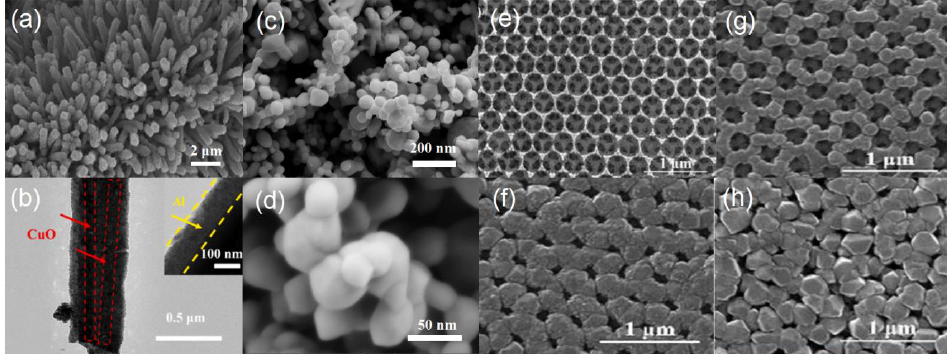
Figure 3. Typical FESEM image ( a , b ) of Al/CuO EMs by electrochemical and magnetron sputtering method [22] Copyright 2021, Journal of Alloys and Compounds, typical FESEM images with low ( c ) and high ( d ) resolution of the superhydrophobic Al/CuO energetic films [54] Copyright 2018, Materials Letters, ( e ) the 3D porous CuO prepared bycolloidal crystal template of polystyrene microspheres [56], followed by ( f ) the 3D Al/CuO EMs after magnetron sputtering of Al with different thicknesses of ( f ) 200 nm, ( g ) 100 nm, and ( h ) 300 nm, respectively. Copyright 2020, Chemical En- gineering Journal.